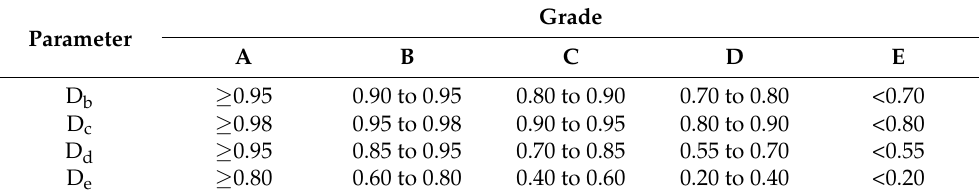
Table 4. Evaluation criteria based on the different parameters.